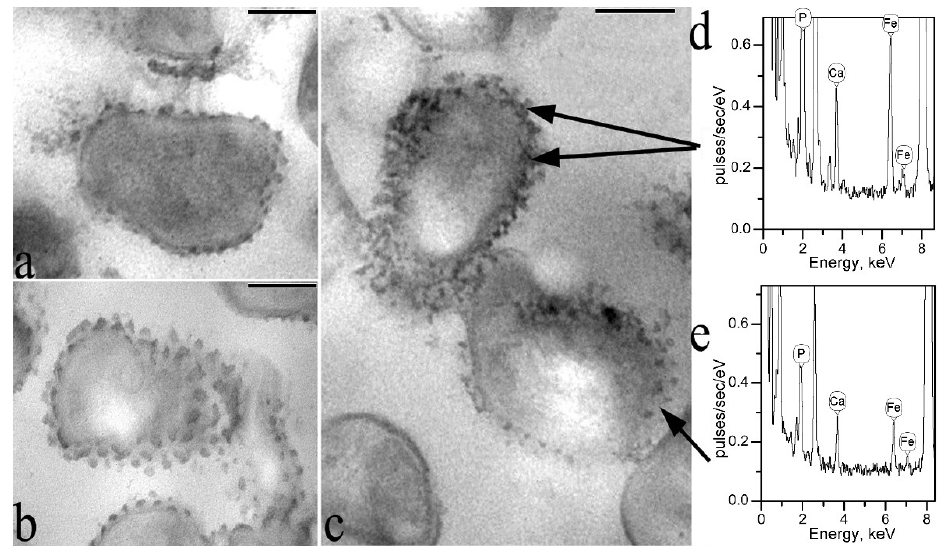
Figure 4. Transmission electron microscopy combined with X-ray microanalysis. Ultrathin unstained sections of the cells of the strain F2E after incubation in medium with copper sulfate CuSO 4 ( a ); nickel chloride NiCl 2 ( b ); with the mineral form of iron, ferrous sulfate FeSO 4 ( c ); ( d ) X-ray spectrum of GSs in a medium with a mineral form of iron; ( e ) X-ray spectrum of the cell surface area between GSs in a medium with a mineral form of iron. Bar—200 nm.